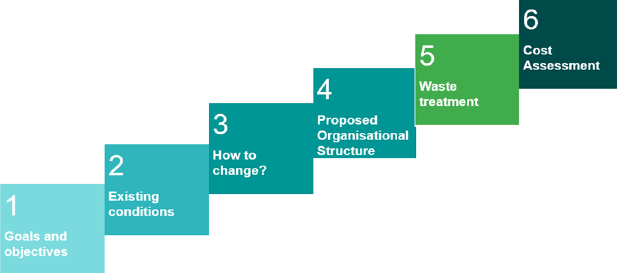
Fig. 6. The proposed Agenda for the solid waste strategy [11].